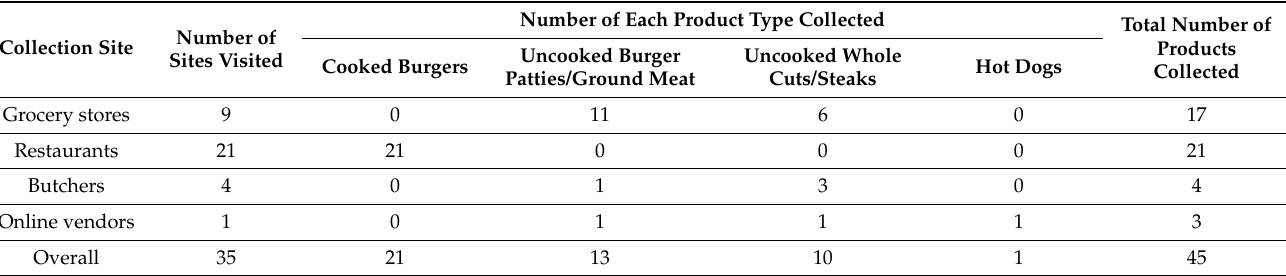
Table 1. Bison products tested in this